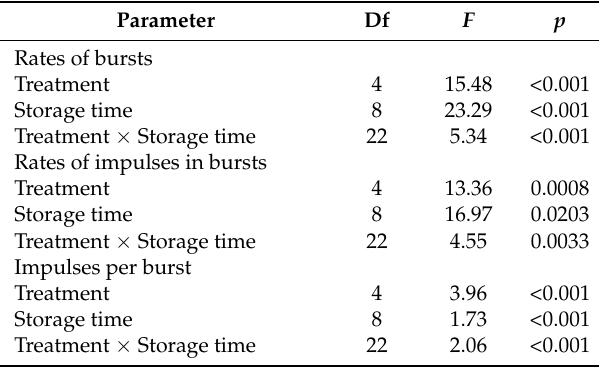
Impulses per burst Treatment 4 3.96